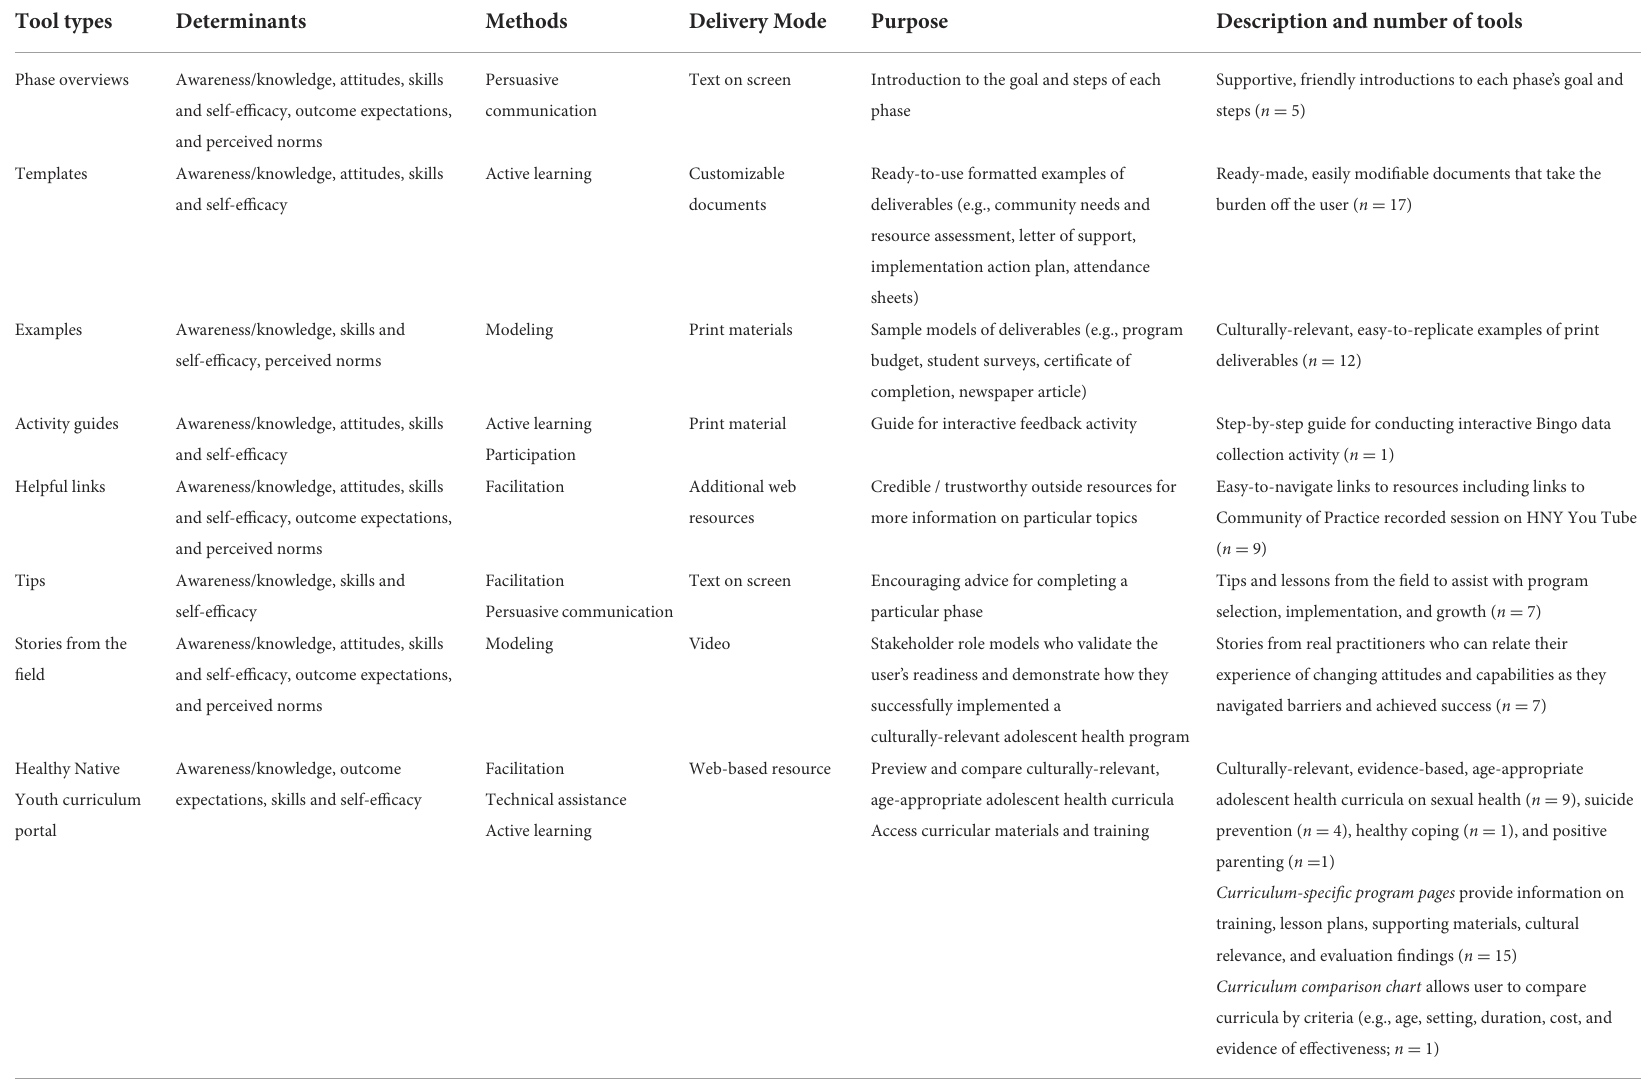
TABLE 5 Implementation Mapping Tasks 3 and 4: Healthy Native Youth Implementation Toolbox tool types: Determinants, methods, delivery mode, purpose, and